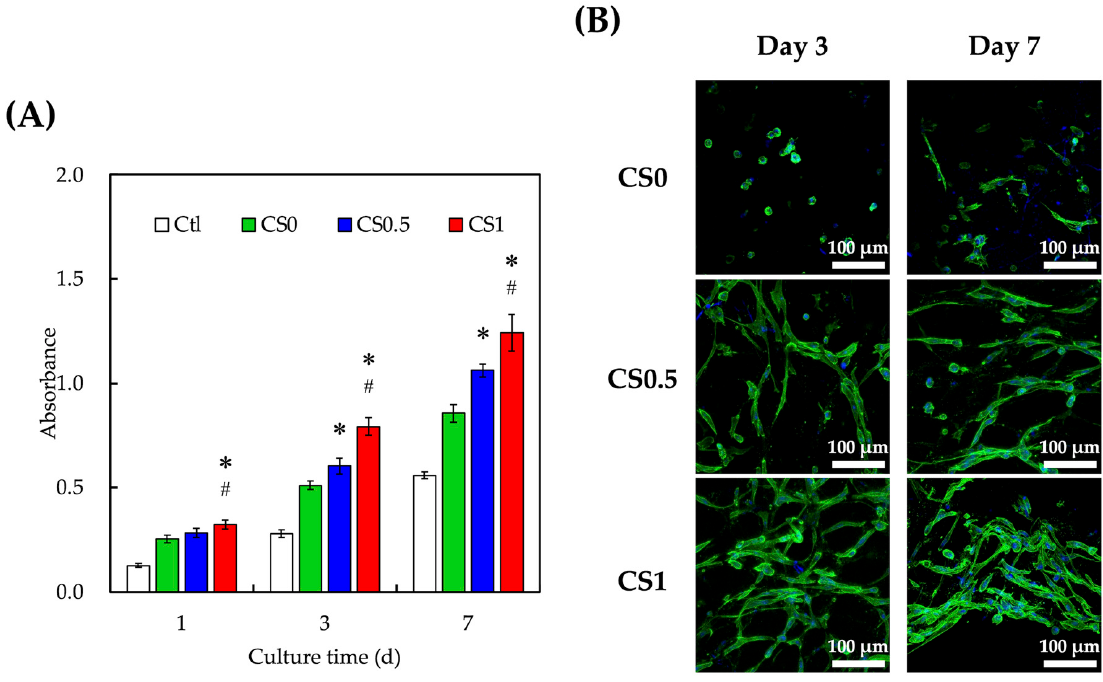
Figure 4. ( A ) Proliferation rates and ( B ) cell morphology of hPDLs-laden auxetic scaffolds. hPDLs growing on traditional culture dishes were used as Ctl. Data presented as mean ± SEM, n = 6 for each group. A p -value of < 0.05 was considered as a significant difference according to the calcula- tion of Scheffe’s multiple comparison test. * represents significant differences when compared to CS0 and # represents significant differences when compared to CS0.5. Immunofluorescence images showed localization of F-actin and nucleus on day 3 and day 7 (green: F-actin; blue: nucleus; scale